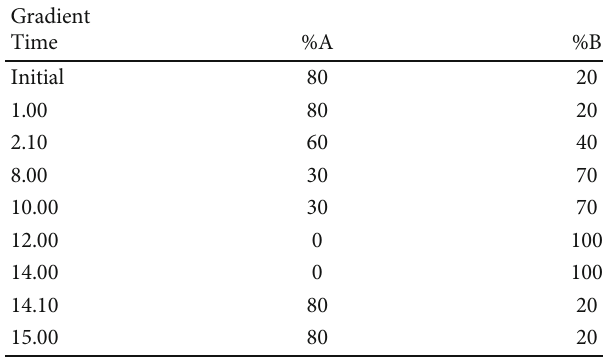
Table 1: Solvent gradient for resolution of polar lipids.